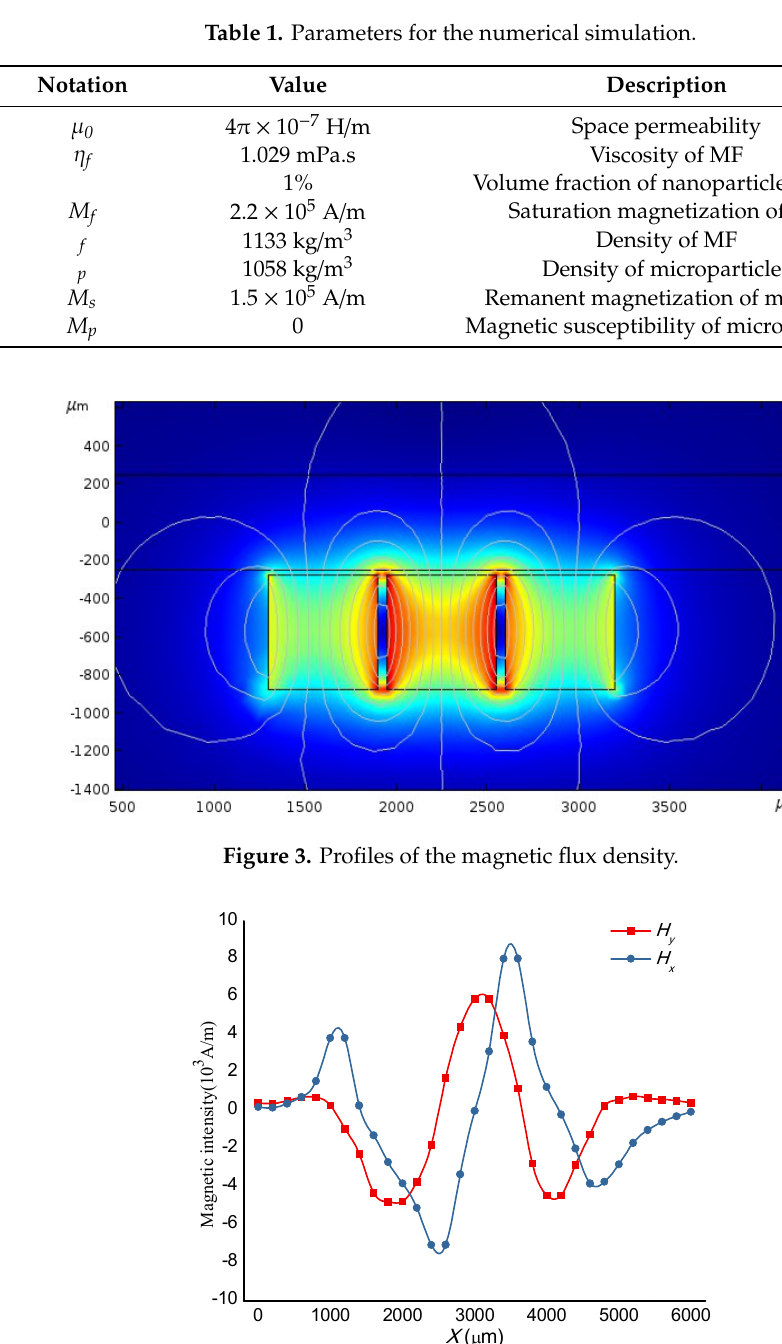
Figure 4. Distribution of the magnetic intensity at y = 200 m.